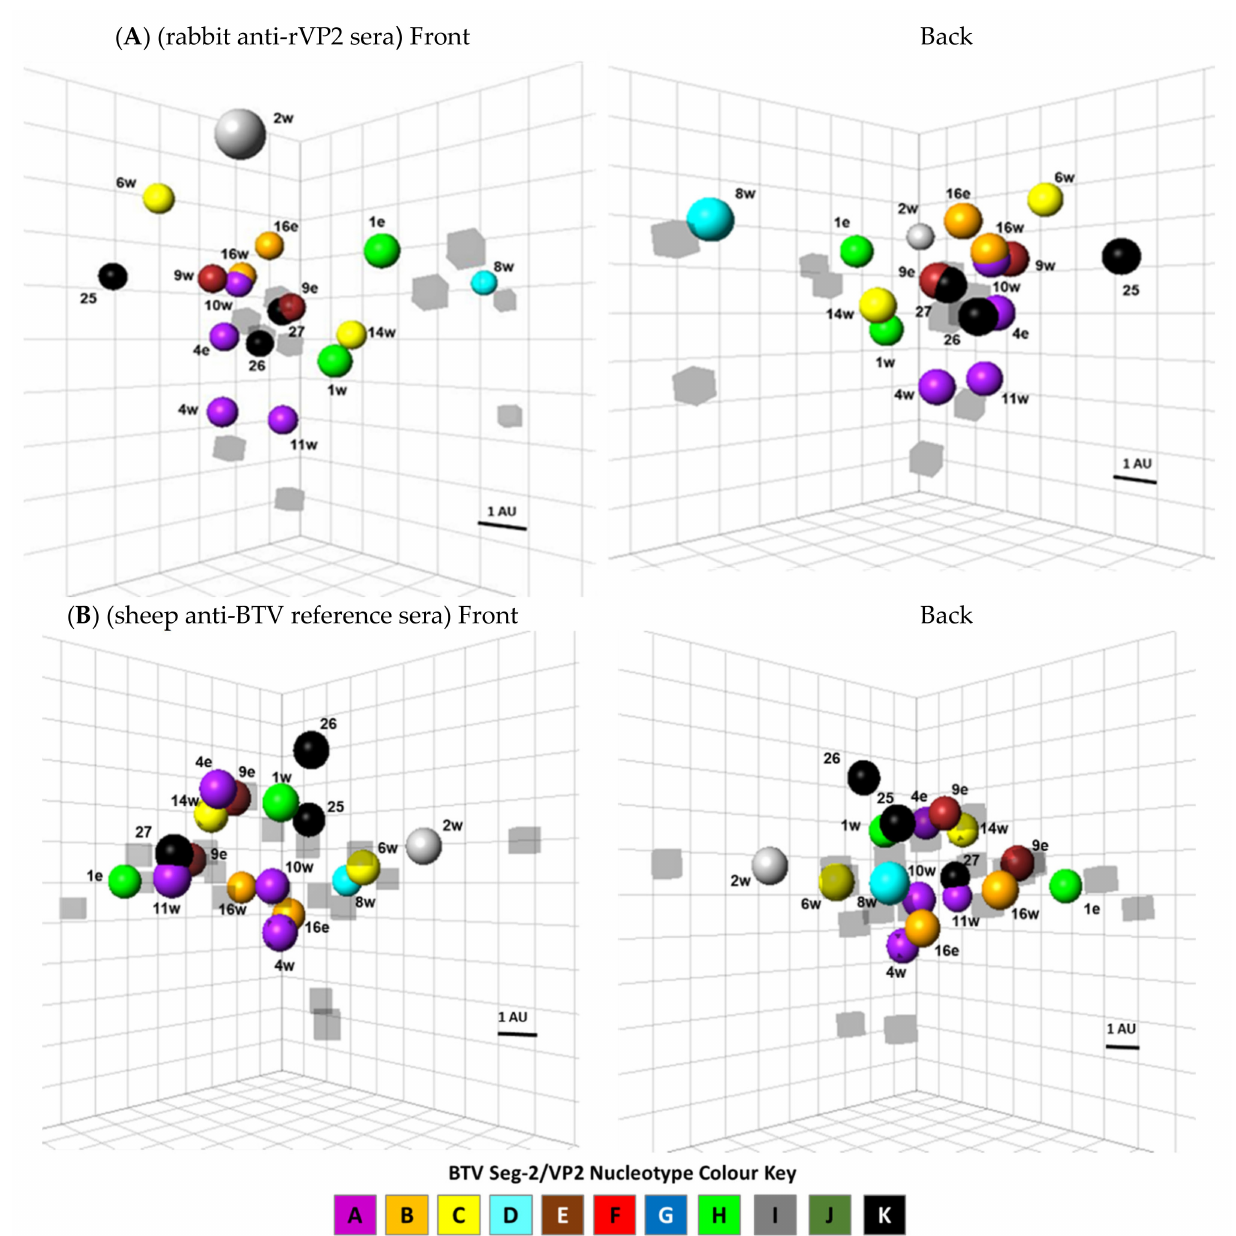
Figure 2. Three-dimensional antigenic maps illustrating cross-relationships between BTV VP2 proteins. Figure 2: Com- putational multidimensional scaling, with multiple repeat simulations, were used to position the seventeen rVP2 protein antigens derived from different BTV strains and topotypes, in 3-dimensional maps, based on their antigenic relationships as determined by I-ELISA, using either ( A ): the ten rabbit anti-BTV-rVP2 sera (Table 2) or ( B ): the 24 sheep anti-BTV reference sera. The coloured spheres representing rVP2 proteins from different BTV serotypes and topotypes (as indicated) are colour-coded by nucleotype (see colour key). The grey cubes represent either the ten rabbit sera (panel A) or the 24 sheep sera (panel B). The scale bar represents one antigenic unit (AU), equivalent to a two-fold change or difference in antibody titre (Tables S2 and S4, for the rabbit and sheep sera respectively). The proteins showing closer antigenic relationships, are therefore positioned closer to each other in the maps. ‘Front’ and ‘Back’ (rotated 180 ◦ ) 3D views are